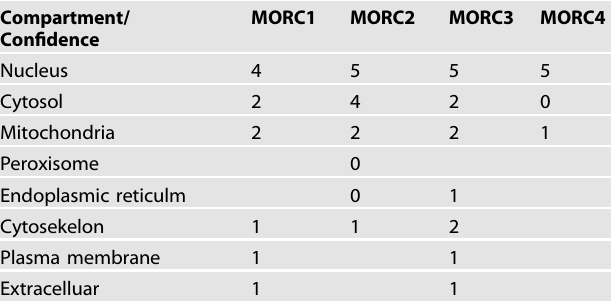
Table 3. The subcellular localization of MORC family derived from PSORT